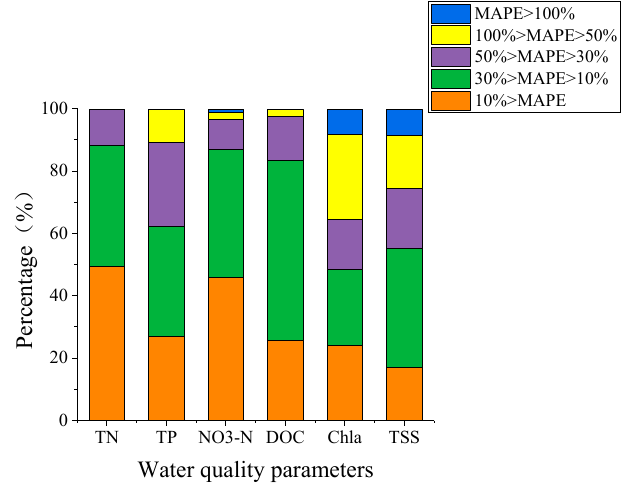
Figure 5. Stacked plots of different MAPE percentages of water quality parameters.